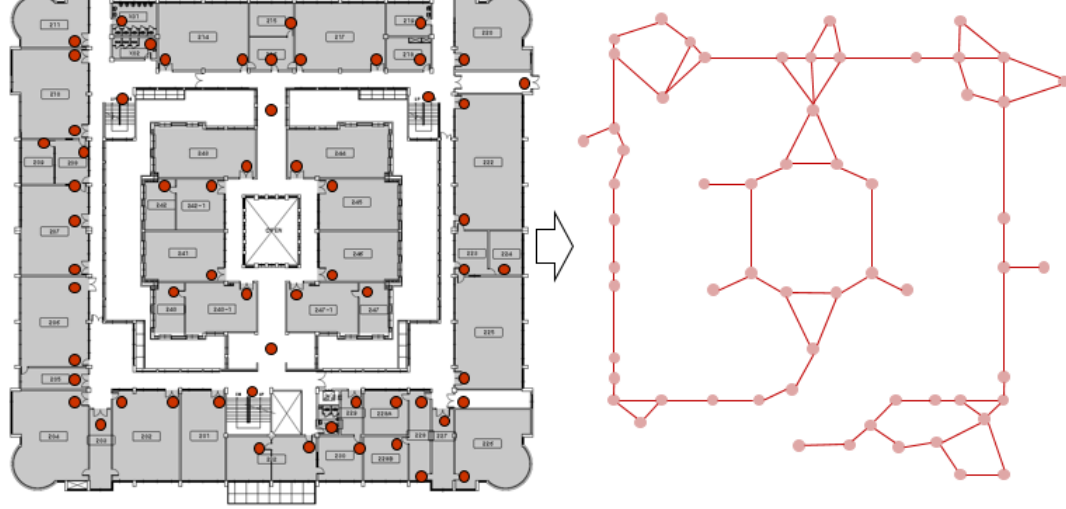
Figure 7. Configuration of the overlay network.